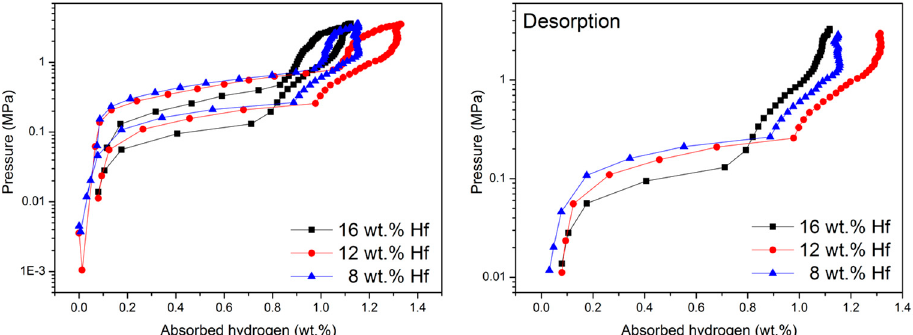
Figure 7. On the left, PCT (Pressure Composition Temperature) curves of TiFe + 8, 12, and 16 wt.% of Hf; On the right, PCT desorption curves of all samples. Measurements were done at room temperature and between 0.5 and 30 bars of H 2 .